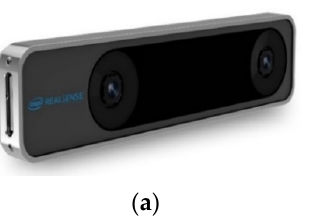
( b ) Figure 5. Descriptions of the connections of the pixhawk to the camera and the companion computer: ( a ) connections of the tracking camera to the companion computer and Pixhawk board; ( b ) telemetry pins on the pixhawk.